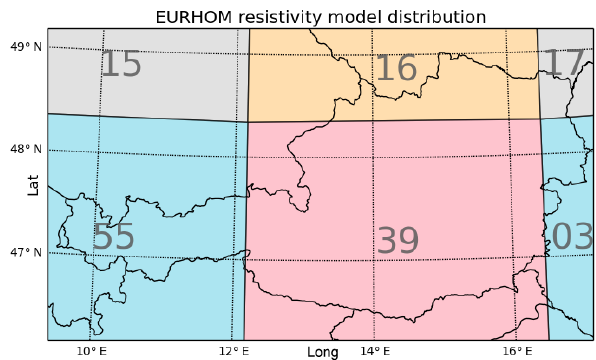
Figure 2. Cells of EURHOM layer resistivity models across Aus-